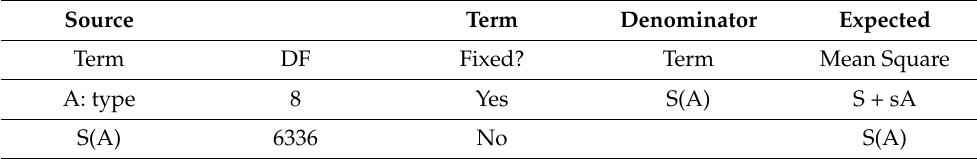
Table 8. Expected Mean Squares Section.